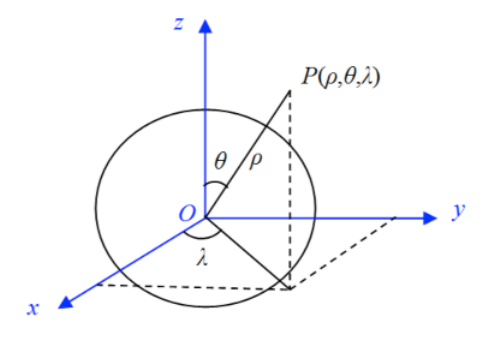
Figure 1. Spherical coordinate system with the Earth center as its